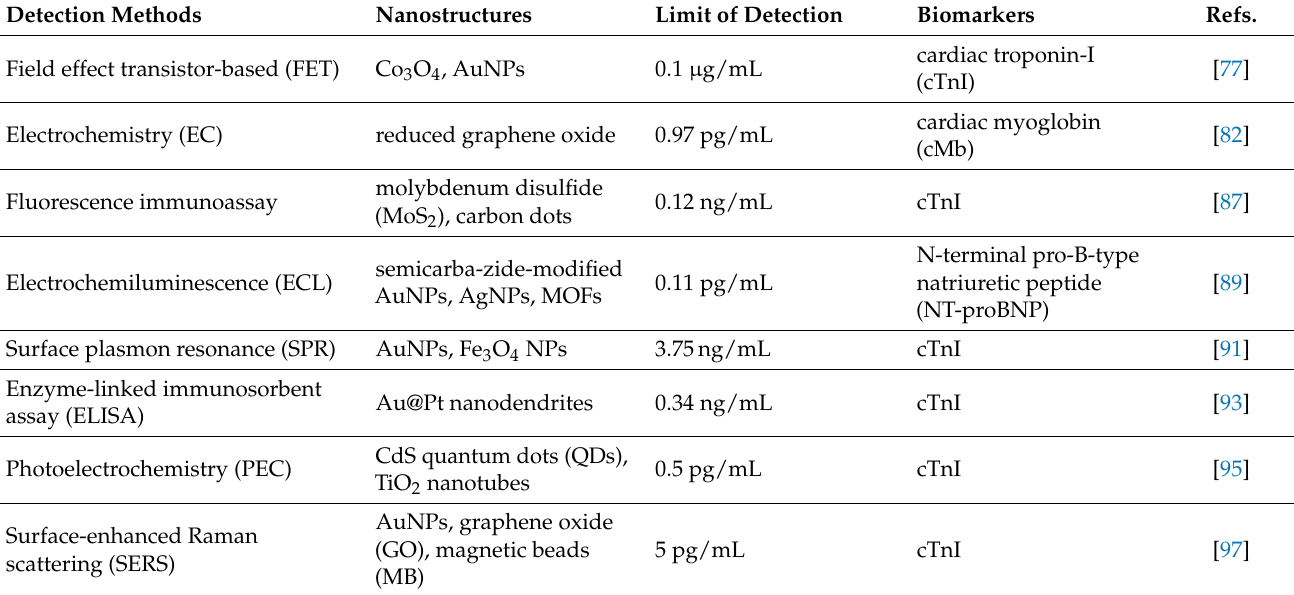
Table 1. Summary of some nanostructures in diagnosis of